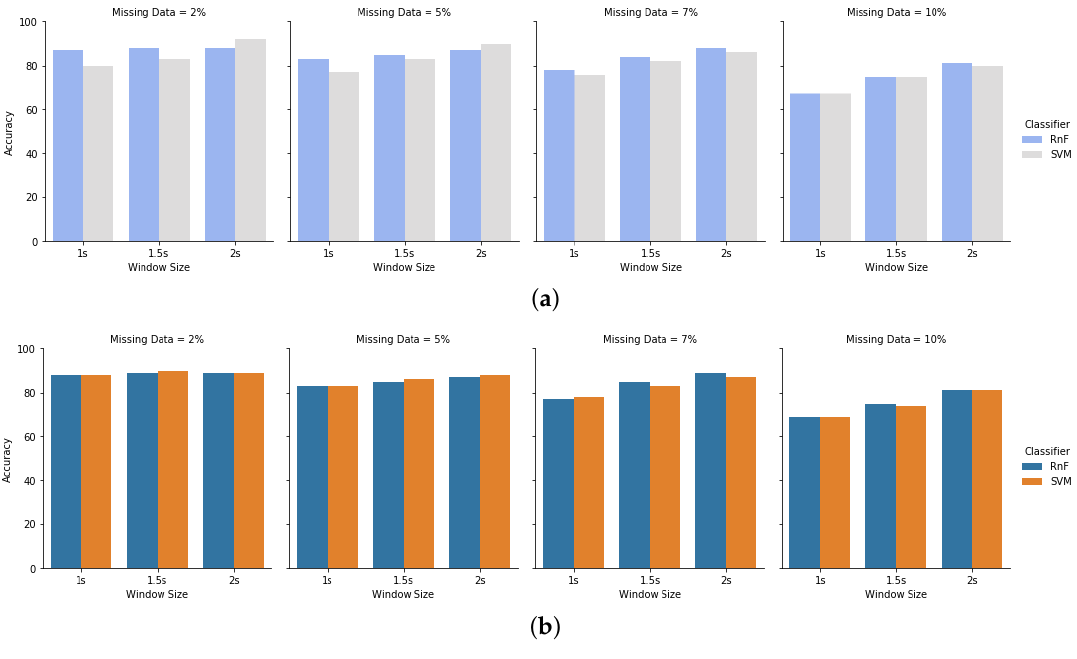
Figure 10. Evaluation of the HASC dataset for window size 1 s, 1.5 s, and 2 s. Missing percentage 2%, 5%, 7%, and 10% in two scenarios: ( a ) HASC dataset for the traditional approach; ( b ) HASC dataset for the proposed